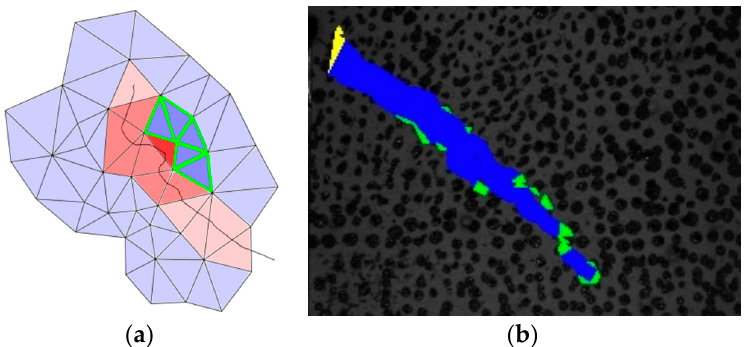
Figure 7. ( a ) False crack tip detection with the neighborhood analysis; ( b ) experimental example with false detections.